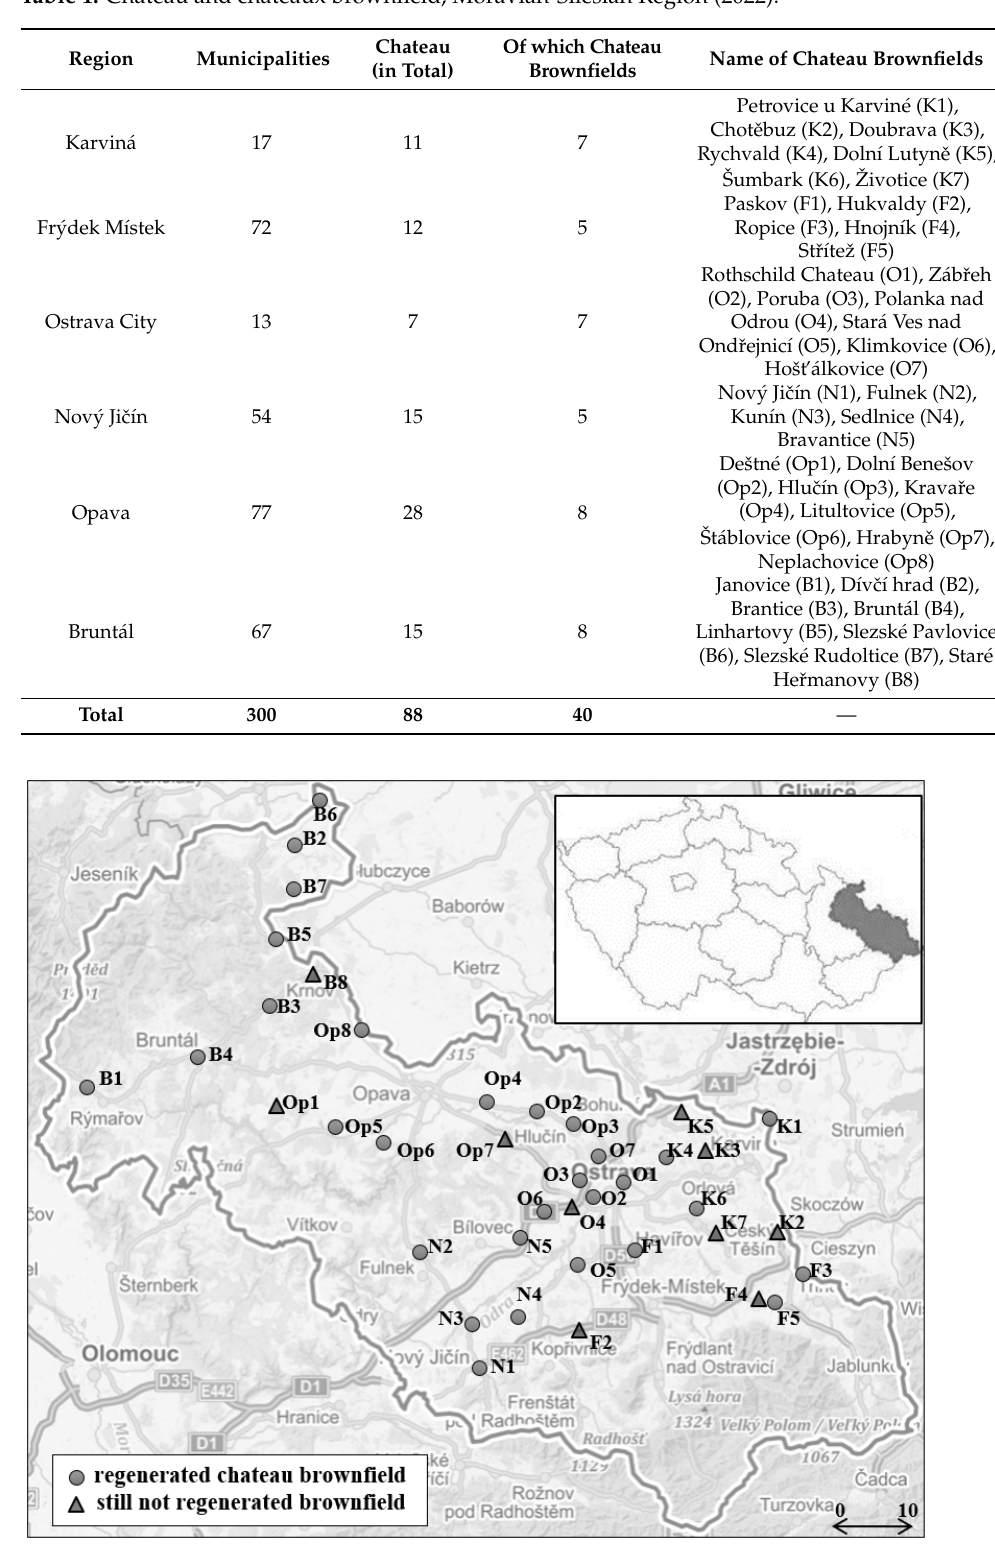
Figure 2. Chateau brownfields and regenerated brownfields in Moravian ‐ Silesian Region (2022).